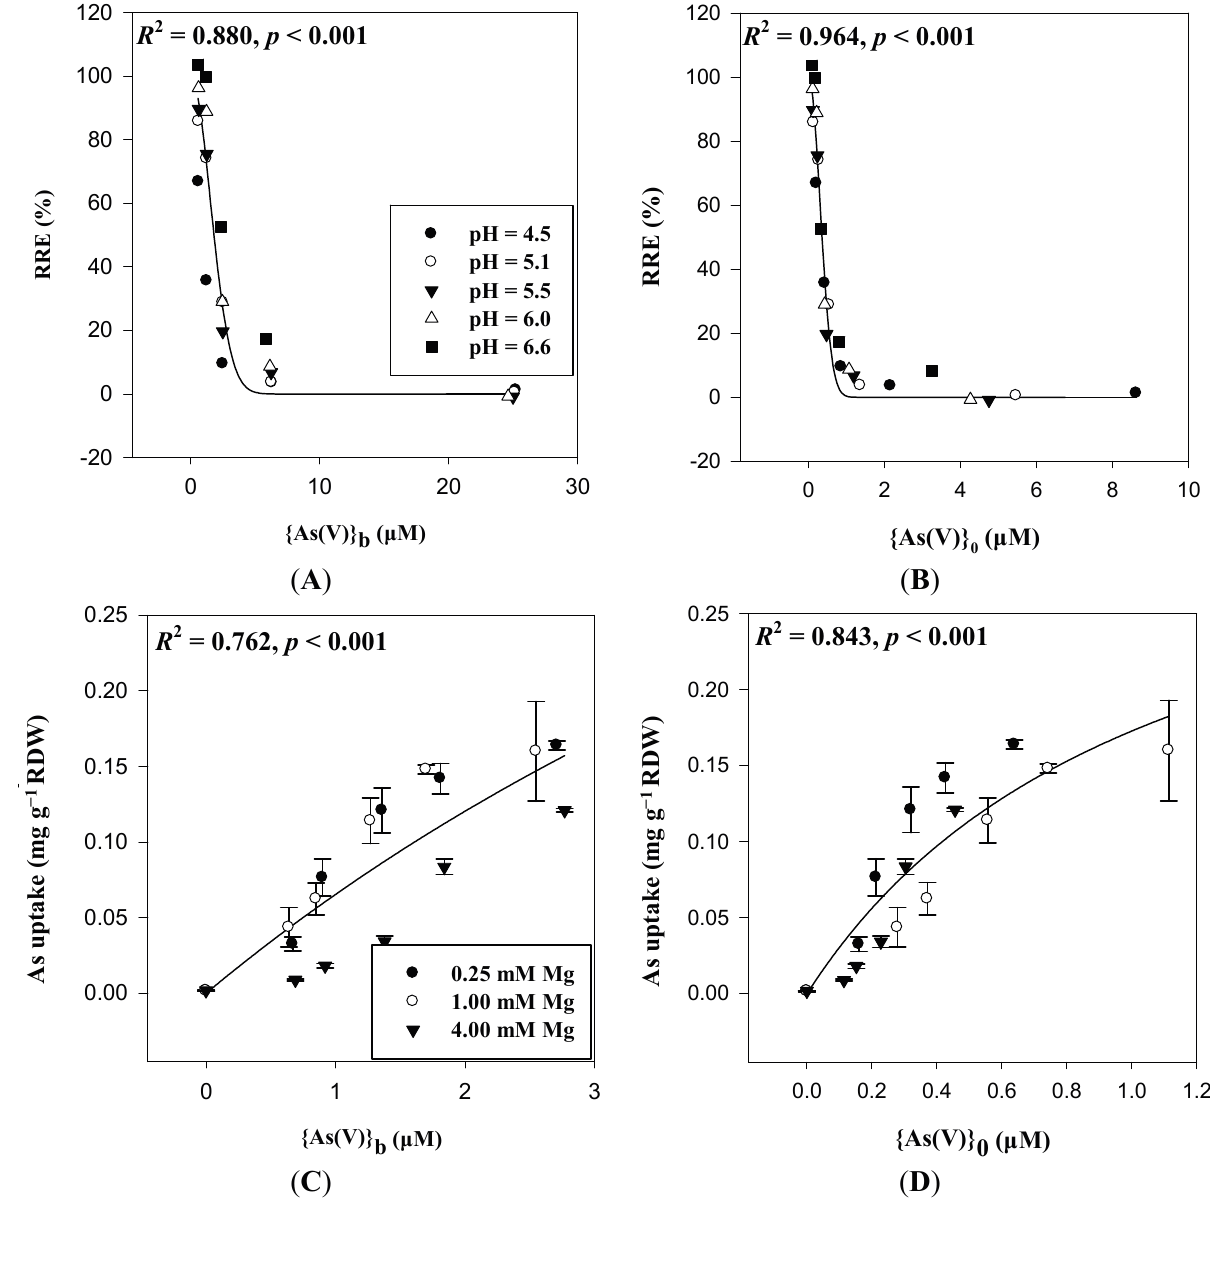
Figure 6. Relative root elongation (RRE, %) and root metal accumulation in wheat seedlings in response to NaH 2 AsO 4 treatments under different pH and Mg levels. Ion activities were expressed as activities in the bulk-phase solutions ({As(V)} b ) and at the PM surface ({As(V)} 0 ). The Weibull Equation RRE = 100/exp[( a {As(V)} b ) b ] (Equation (15)) was used in ( A ); and the Equation RRE = 100/exp[( a {As(V)} 0 ) b ] (Equation (16)) was used in ( B ); The Michaelis-Menten equation as Uptake = a {As(V)} b /( K m + {As(V)} b ) (Equation (17)) was used in ( C ); and the equation as Uptake = a {As(V)} 0 /( K m + {As(V)} 0 ) (Equation (18)) was used in ( D ). Data were obtained from Wang et al.